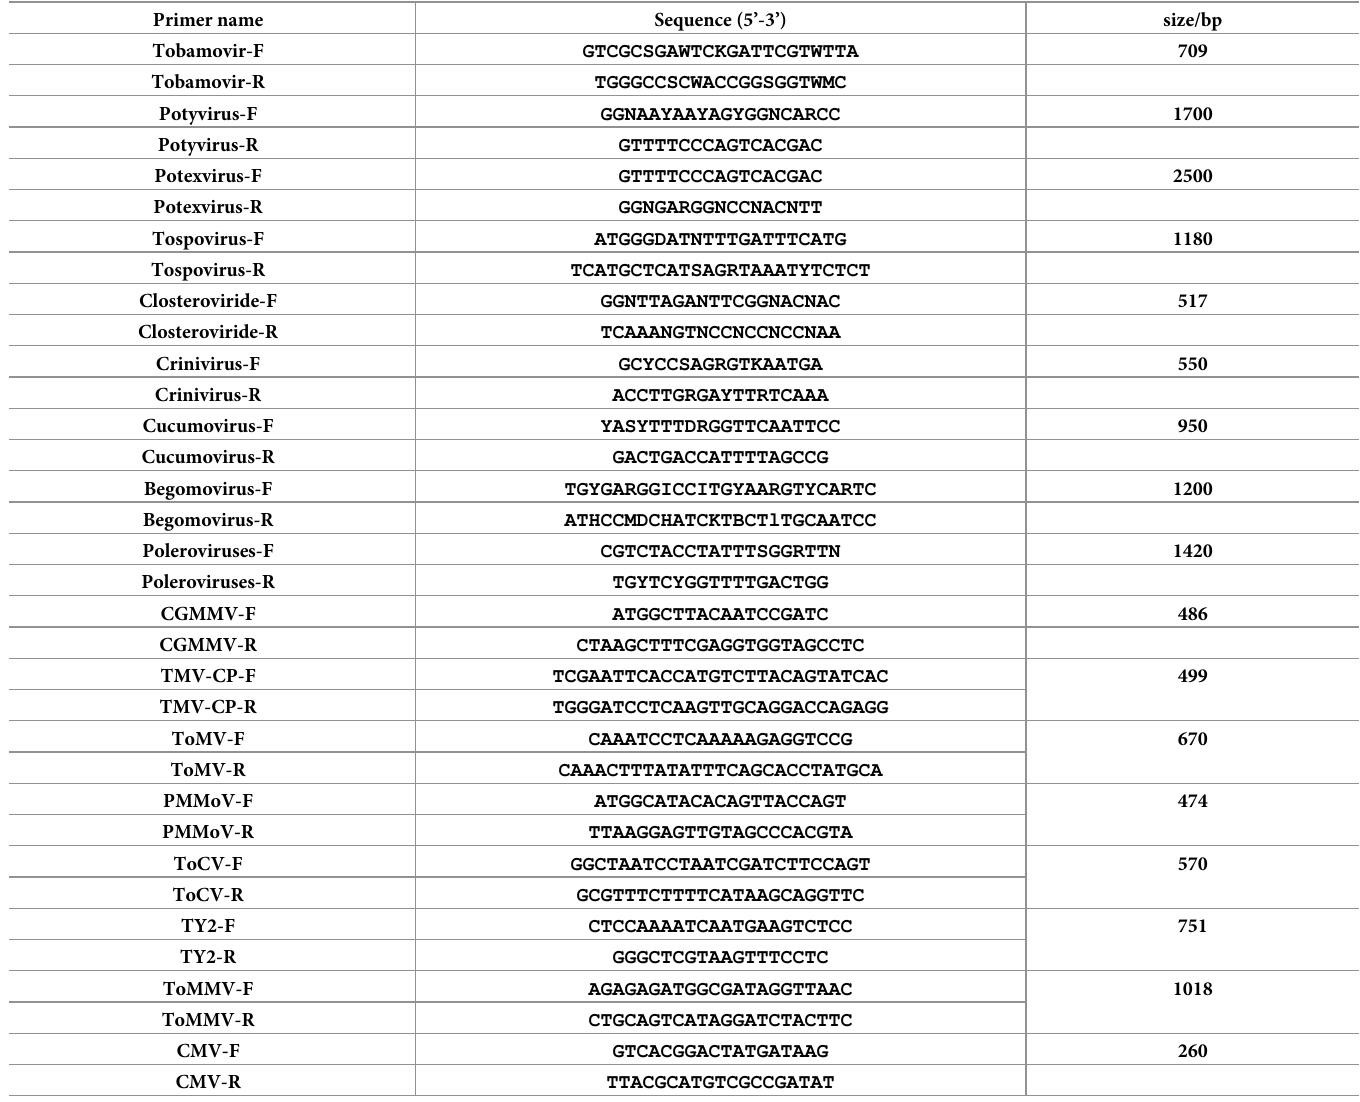
Table 2. Primers used for detection of the main vegetable viruses in this study. Primer